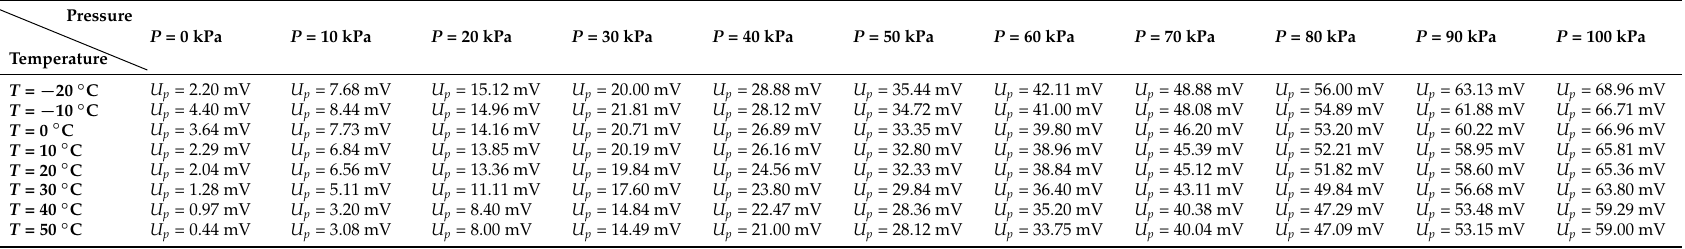
Table 1. The calibration sample data of the SiNW pressure sensor for the training of the PSO–BP compensation algorithm, which are obtained with pressures from 0 to 100 kPa and with temperatures from − 20 to 50 ◦